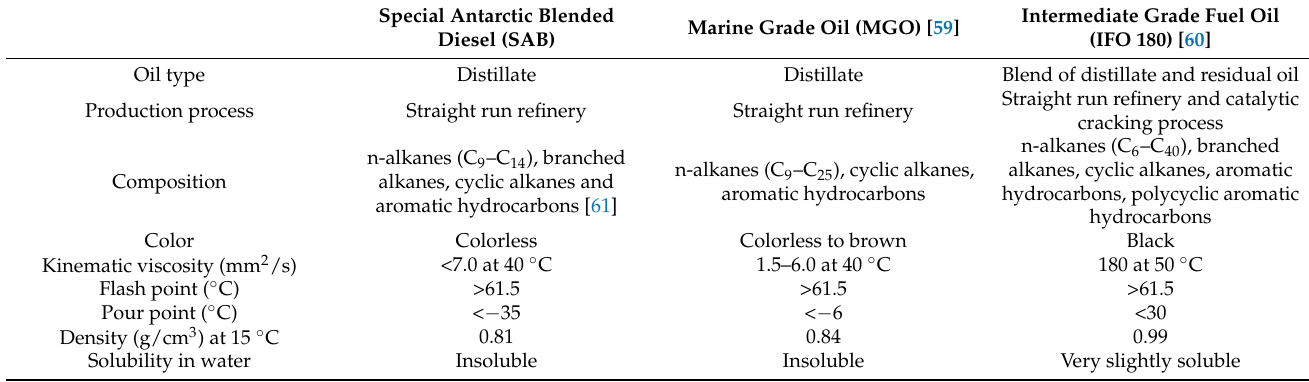
Table 3. Comparison of different types of diesel fuel used in Antarctica and sub-Antarctic